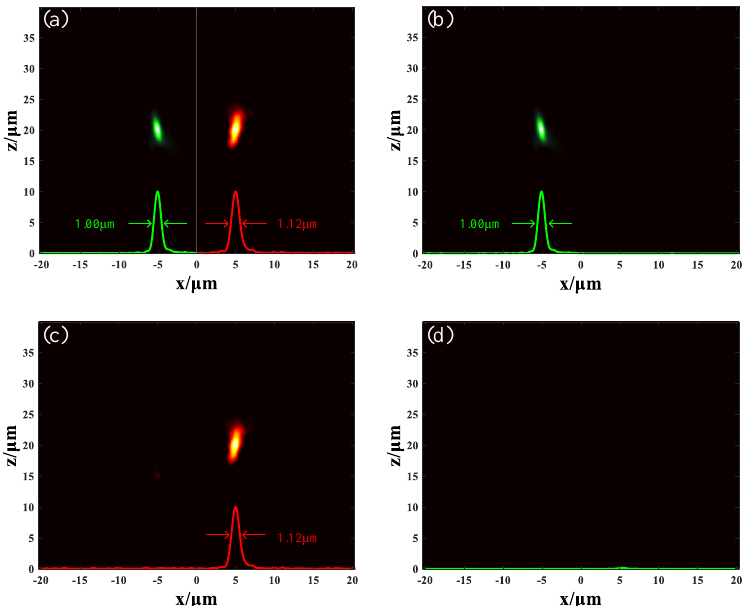
Figure 7. The light field distribution of metalens M 3 . The red profile and green profile indicate the 1.55 μm and 1.31 μm light respectively . ( a ) The GST in both sections are in amorphous state. ( b ) The GST in section A stays in amorphous state but the GST in section B stays in crystalline state. ( c ) The GST in section A stays in crystalline state but the GST in section B stays in amorphous state. ( d ) The GST in both sections are in crystalline state. Nanomaterials 2019 , 9 , x FOR PEER REVIEW